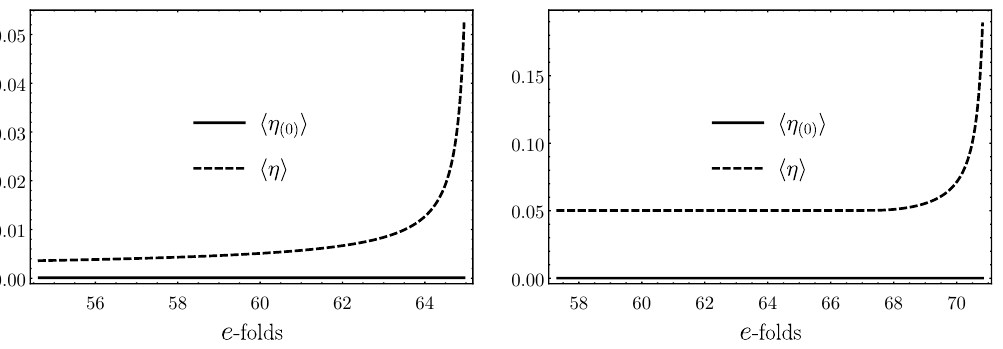
Figure 8 . Evolution of (cid:17) for set 1 (left) and set 2